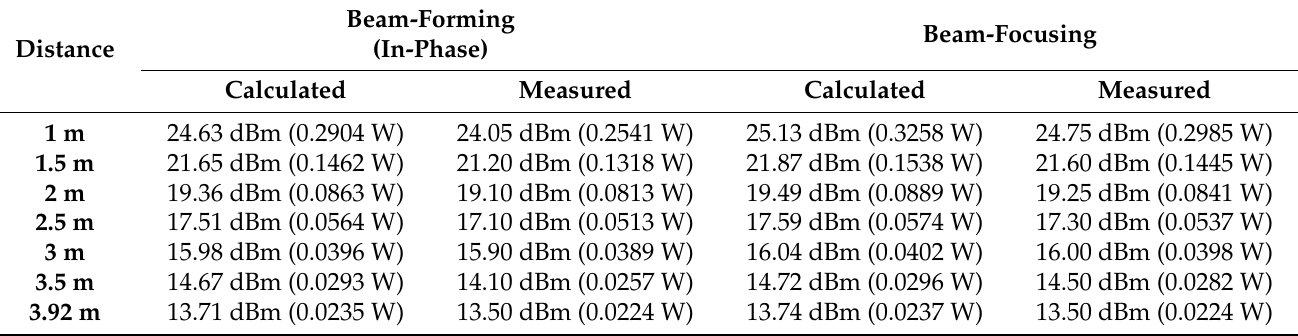
Table 2. Experimental results of 2.482 GHz received power when total transmitted power is 40 dBm (=10 W).